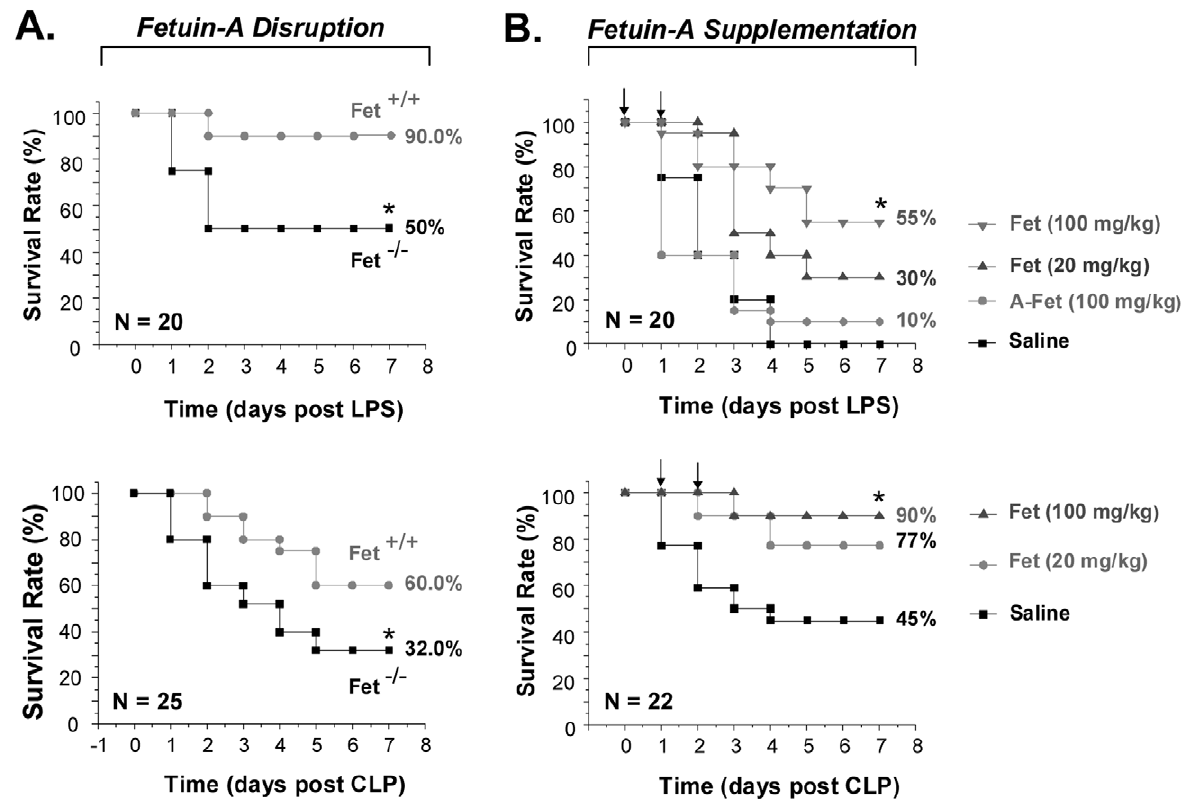
Figure 3. Distinct effects of fetuin-A depletion or supplementation on endotoxemic and septic lethality. A ). Disruption of fetuin-A expression rendered mice more susceptible to lethal endotoxemia and sepsis. Sex-, body weight-, and genetic background-matched wild-type or fetuin- A-deficient (fet 2 / 2 ) C57BL/6 mice (male, 27–29 g) were subjected to endotoxemia or sepsis, and animal survival was monitored. The Kaplan-Meier method was used to compare mortality rates between groups of two independent experiments with similar results. *, p , 0.05 vs wild-type mice in endotoxemia ( Top Panel ) or sepsis ( Bottom Panel ). B ) . Supplementation of fetuin-A protected mice against lethal endotoxemia or sepsis. Balb/C mice were challenged with lethal dose of endotoxin, and intraperitoneally administered with saline (0.2 ml/mouse), fetuin-A (‘‘Fet’’), or asialofetuin-A (‘‘A- Fet’’) at + 0.5 and + 24 h after endotoxemia. In separate experiments, Balb/C mice were subjected to sepsis (induced by CLP), and administered with fetuin-A at indicated doses at + 24, and + 48 h after CLP, and animal survival was monitored. *, P , 0.05 versus